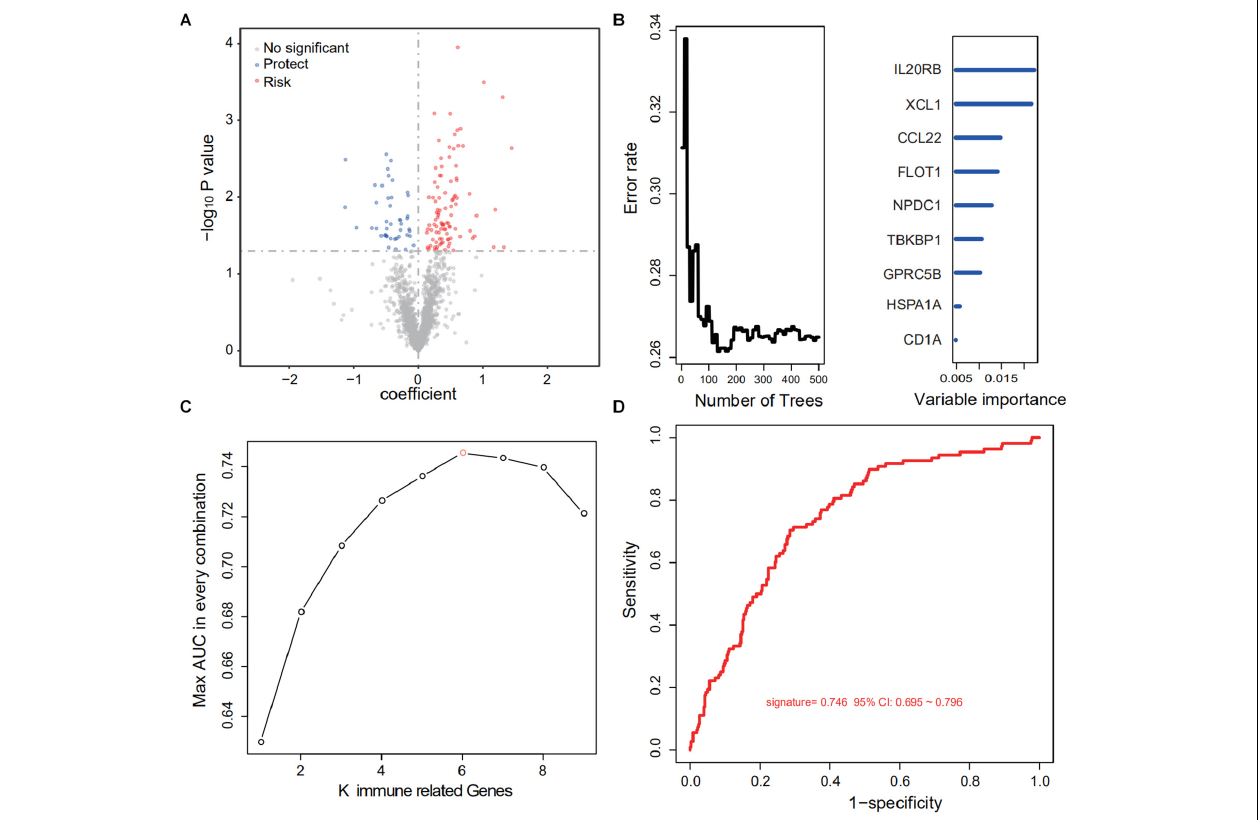
FIGURE 2 | Identification of a six-IRG panel for prognosis prediction. (A) Univariate Cox regression of 1,684 IRGs regarding patient survival. IRGs with statistical significance ( n = 143) were marked blue if protective or red if risk factors. (B) RSFA was used to select highly survival-correlated IRGs. Nine genes were enrolled. (C) Full-scale recombination of the nine IRGs was conducted to rule out overfitting (combinations, n = 511). A six-gene panel with an AUC of 0.746 was selected as the optimal prediction panel. (D) ROC curve of the designated IRG panel.